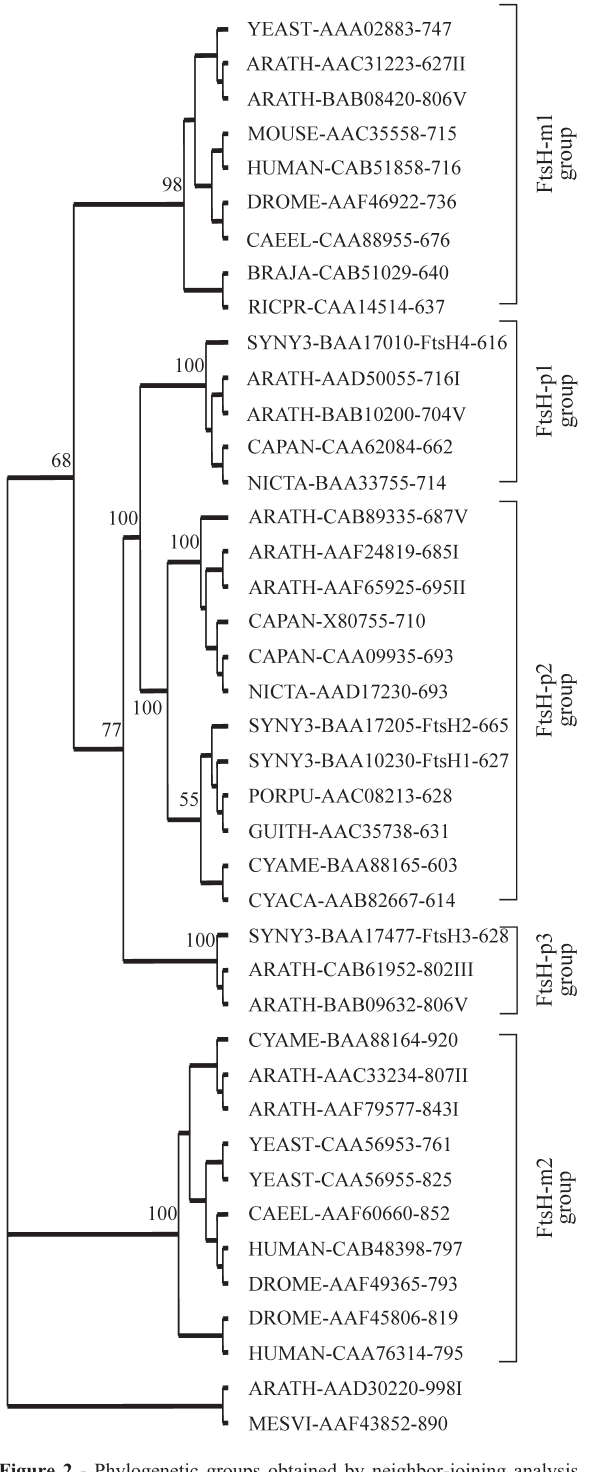
Figure 2 - Phylogenetic groups obtained by neighbor-joining analysis. Bootstrap support is given as the percentage of 10000 re-samplings in which a given node appeared. The protein sequences are identified through their Swiss-Prot species identification code, accession number and amino acid number (all items are described in Table I). In the Arabidopsis protein sequences, the roman numeral after the amino acid number indicates the chromosome in which the FtsH encoding gene is lo-